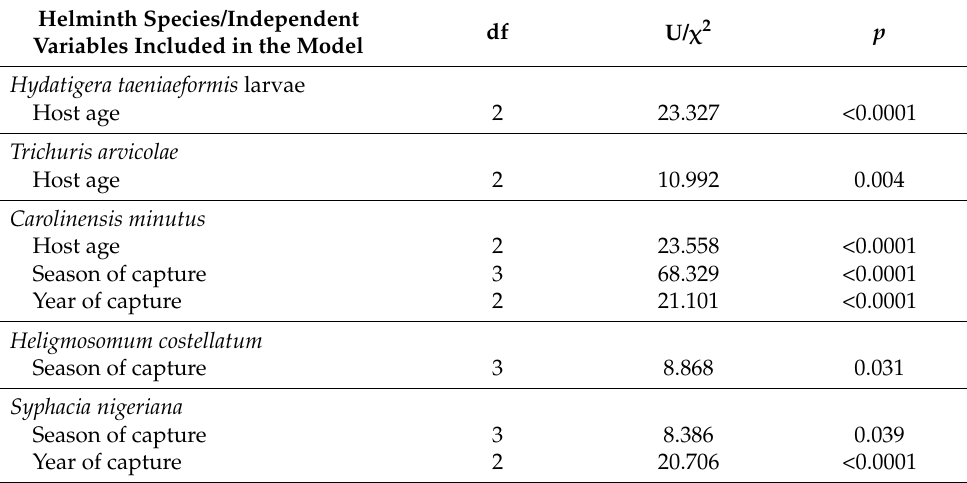
Table 14. Values of Mann–Whitney (U) and Kruskal–Wallis ( χ 2 ) tests, with associated probabilities ( p ), applied in the analyses of the helminth component species abundances of Microtus lusitanicus from Asturias. The Mann–Whitney test was applied to host sex and the Kruskal–Wallis test was applied to host age, season and year of capture. Only significant results are